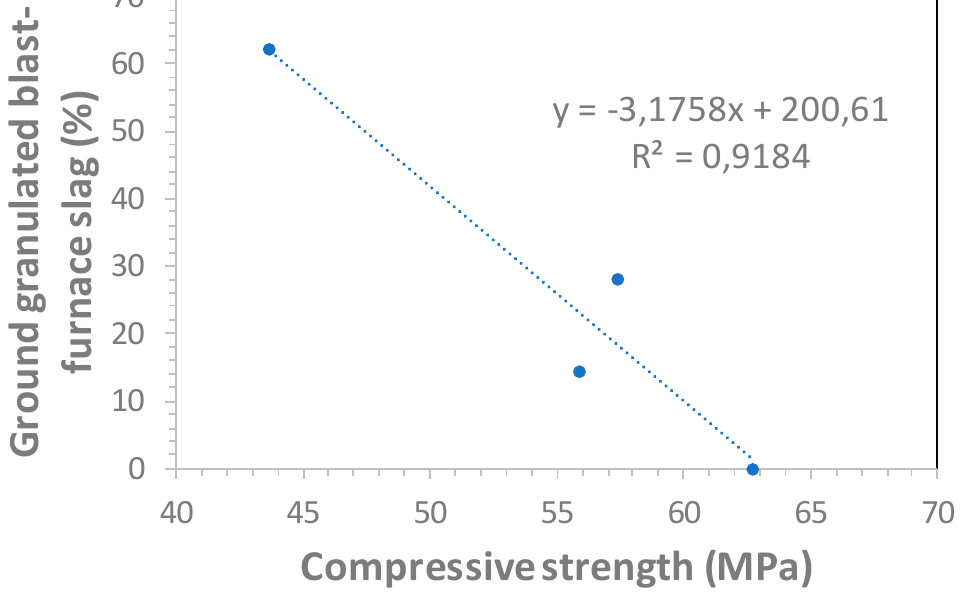
Figure 3. Compressive strength at 28 days measured in GGBFS mortars. From top to down, CEM III/B 32.5 N-LH / SR, CEM III / A 42.5 N, CEM II / A-S 42.5 N, and CEM I 52.5 R-SR 3 mortars.